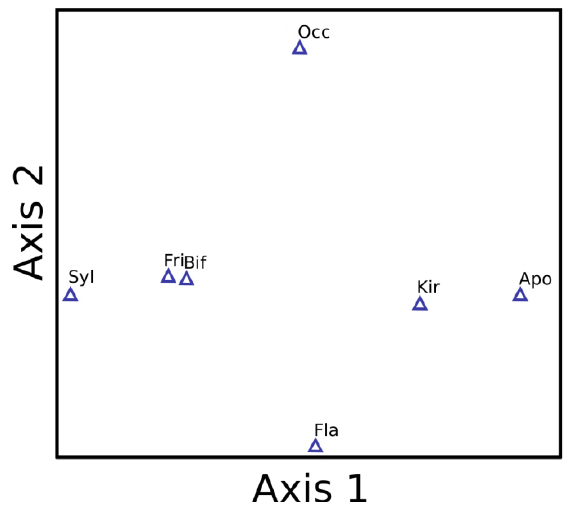
F IGURE 2. Bray-Curtis ordination of bumble bee species according to use of 34 host-plants near Gothic, Colorado (data from Pyke 1982, Table 2). Short-tongued species: B. sylvicola (Syl), B. frigidus (Fri), B. bifarius (Bif), B. occidentalis (Occ). Medium-tongued species: B. flavifrons (Fla). Long-tongued species: B. balteatus (Kir), B. appositus (Apo). B. sylvicola clusters with other short-tongued species; excluding B. occidentalis, which